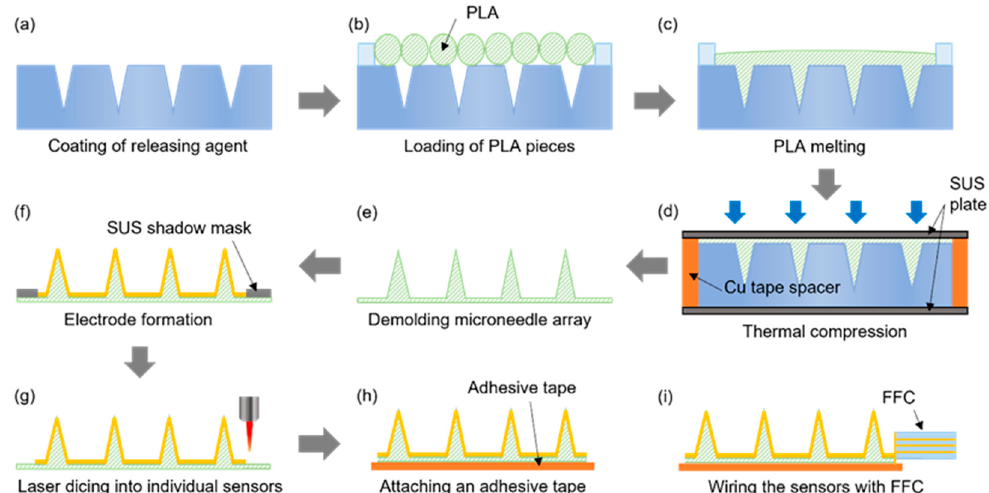
Figure 3. The procedure used to fabricate microneedle sensors. ( a ) Coating of releasing agent. ( b ) Loading of PLA pieces. ( c ) PLA melting. ( d ) Thermal compression. ( e ) Demolding microneedle array. ( f ) Electrode formation. ( g ) Laser dicing into individual sensors. ( h ) Attaching an adhesive tape. ( i ) Wiring the sensors with FFC.